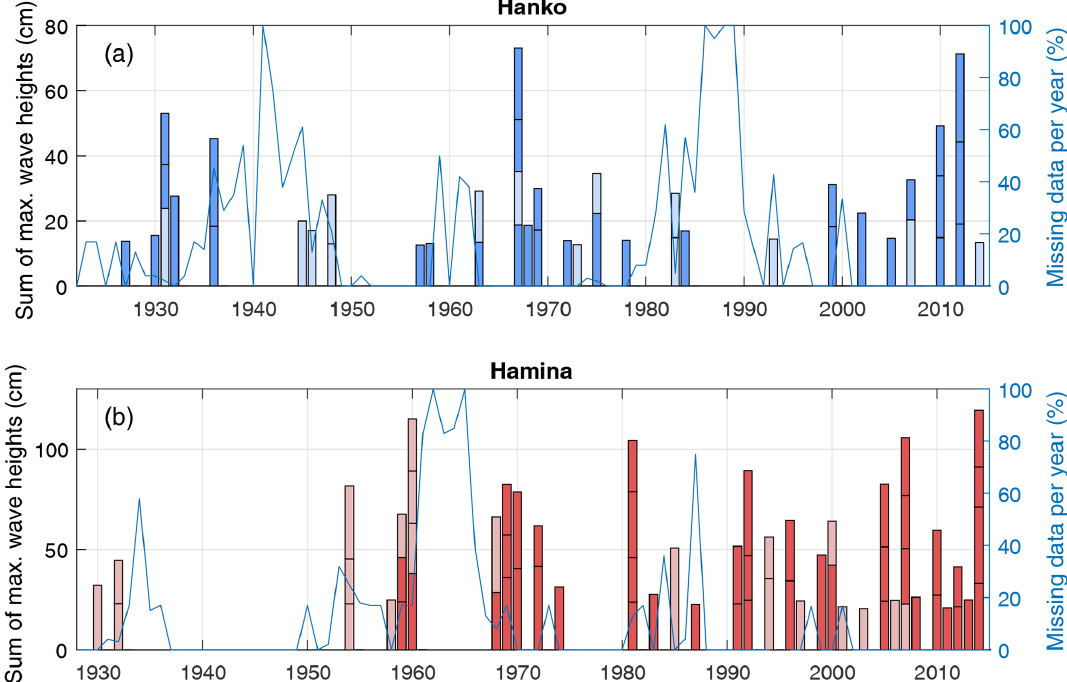
Figure 5. Meteotsunamis identified in the sea level data from the 1920s to 2014 for (a) Hanko and (b) Hamina. The events of each year are stacked so that the height of the column corresponds to the sum of maximum wave heights of the events during a given year. Dark- coloured events have been confirmed from air pressure data; the light-coloured events are potential meteotsunamis whose atmospheric origin is uncertain. The blue curves show the proportion of missing or damped data per